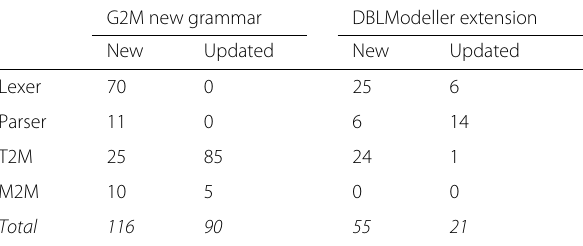
Table 2 Lines of code to support the SharePoint schema G2M new grammar